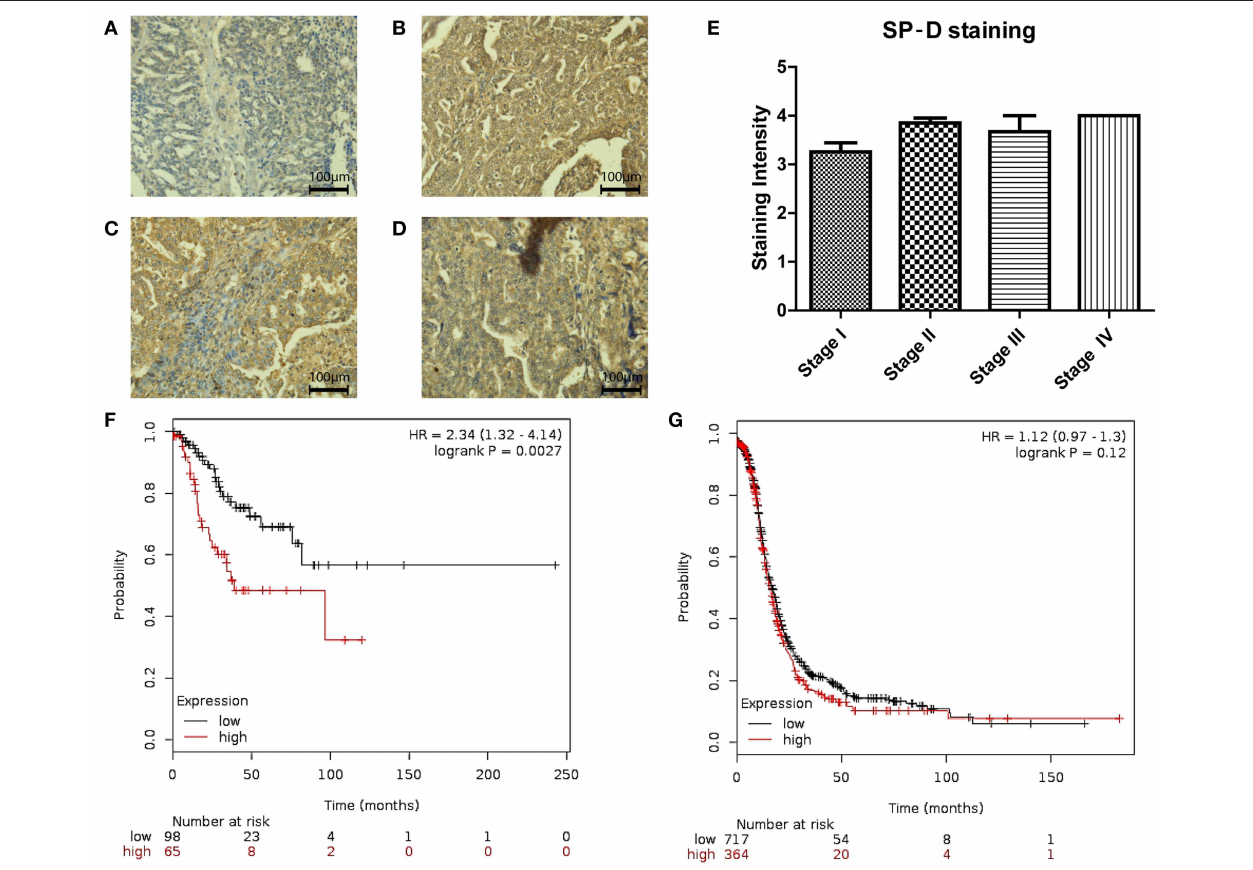
FIGURE 4 | Immunohistochemistry for SP-D expression in different stages of ovarian tissue array clinical samples (40 x magnification): serous papillary cystadenocarcinoma stage I (A) , serous papillary cystadenocarcinoma stage II (B) , serous papillary cystadenocarcinoma stage III (C) and serous papillary cystadenocarcinoma stage IV (D) . A nearly significant up-regulation of SP-D was observed in stage II OC compared to stage I OC ( p = 0.053; E ). Stratification of PFS in Stages I and II (F) against stages III and IV (G) . There was a significant survival improvement in low SP-D cohort compared to patients with high SP-D expression only in Stages I and II ( p = 0.0027, and p = 0.12, respectively).